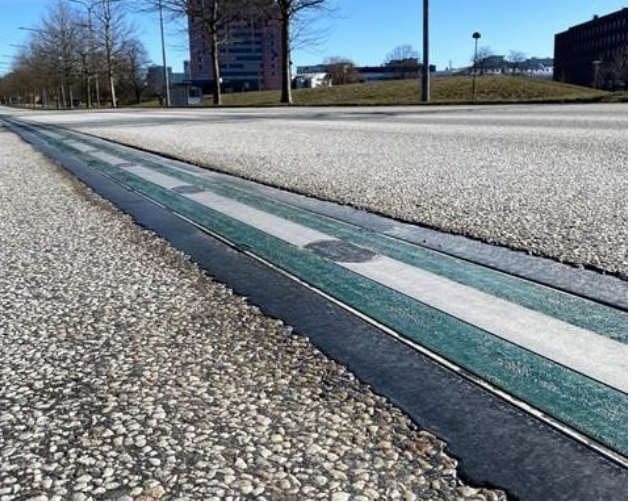
Figure 1. One of the test sites of conductive ERS on public roads in Sweden